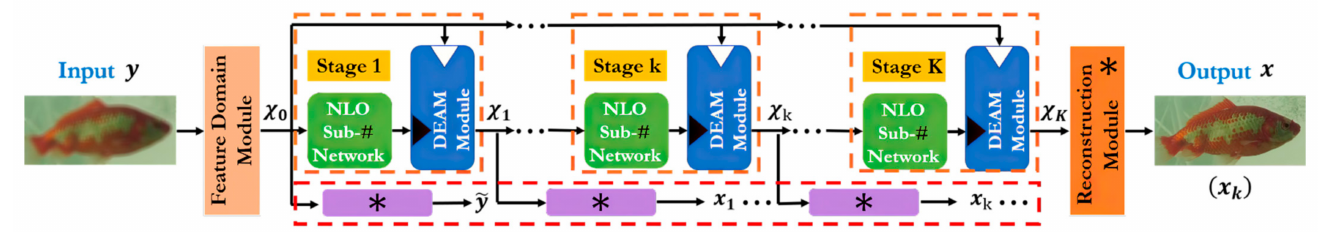
Figure 4. The general framework of the data preprocessing process. De-noise adjustments such as brightness, color shift, and sharpness of the image data first. The subsequent first-level denoising sub-image input incorporates ACP into the optimized new deep neural denoising architecture. It consists of a feature domain module, a reconstruction module, and k iteration stages based on a nonlinear operation (NLO) subnet and a dual attention mechanism (DEAM) module. The modules marked with * and # mean that the parameters of these modules are